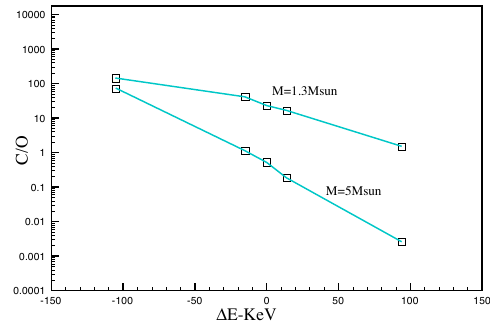
Figure 16: The C/O ratio obtained in the evolution of Figure 8.22: The C/O ratio and obtained in the Figure 8.23: The C/O ratio and obtained in the low mass stars (1 . 3 M and 5 . 0 M ) upon a hypothetical (cid:12) (cid:12) evolution of low mass stars ( 1 . 3 M and 5 . 0 M ) evolution of high mass stars ( 15 M change in the location of the resonance in 12 C.   upon a hypothetical change in the location of the upon a hypothetical change in the location of the resonance in 12 C . resonance in 12 C .